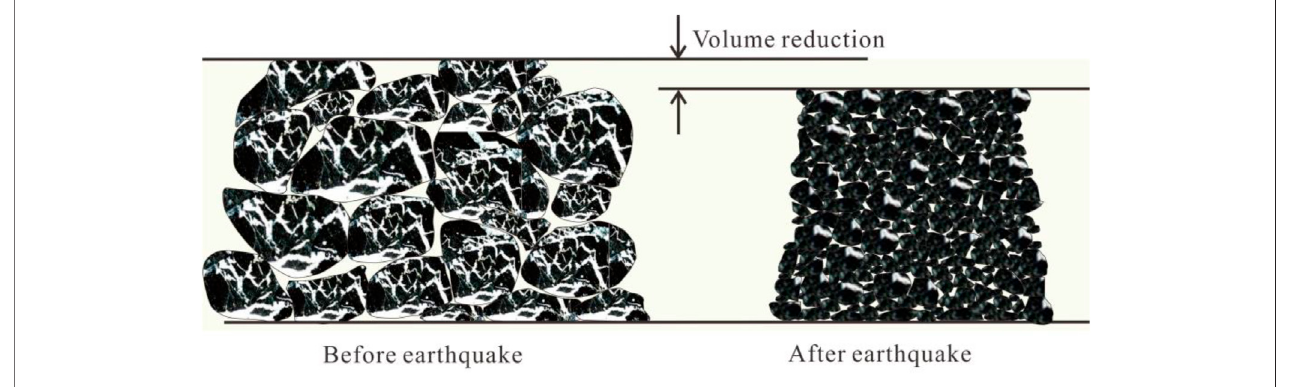
FIGURE 14 | Schematic diagram of liquefaction